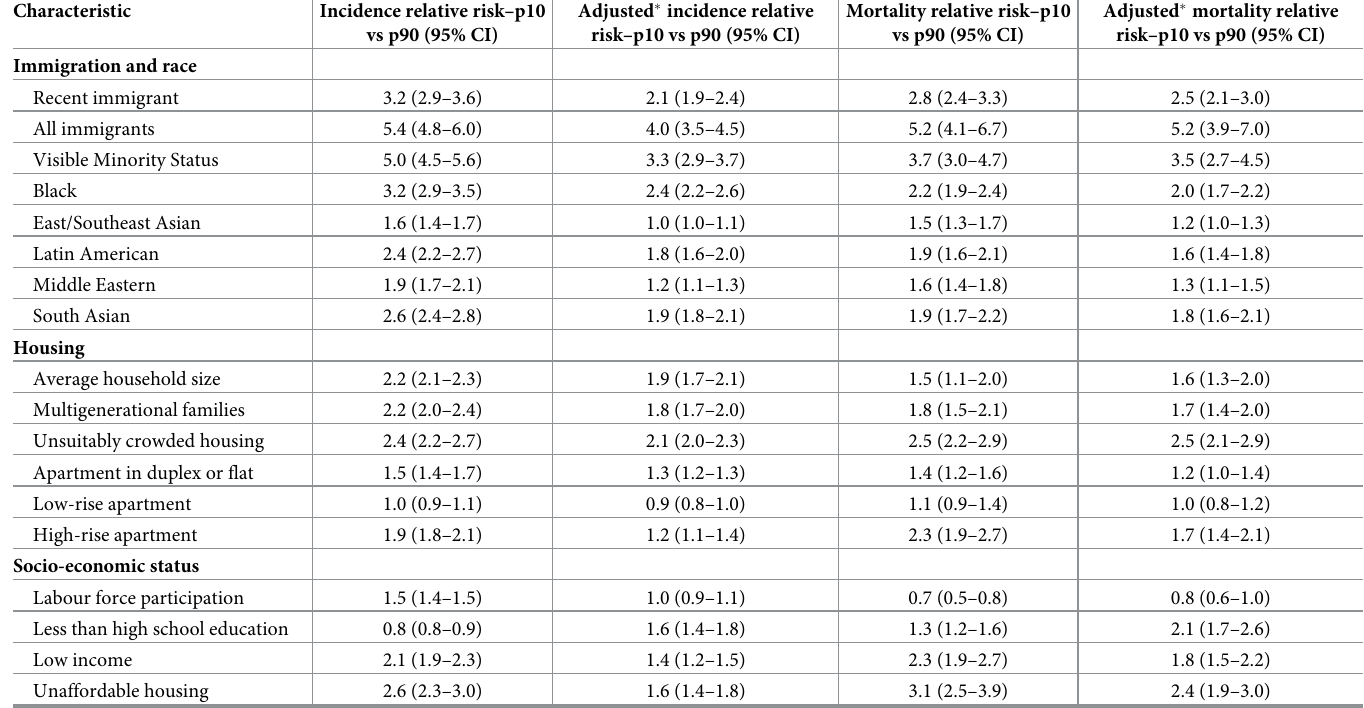
Table 2. Relative risks of COVID-19 incidence and mortality between 10 th and 90 th percentile of each neighbourhood-level proportion of socio-demographic characteristics.